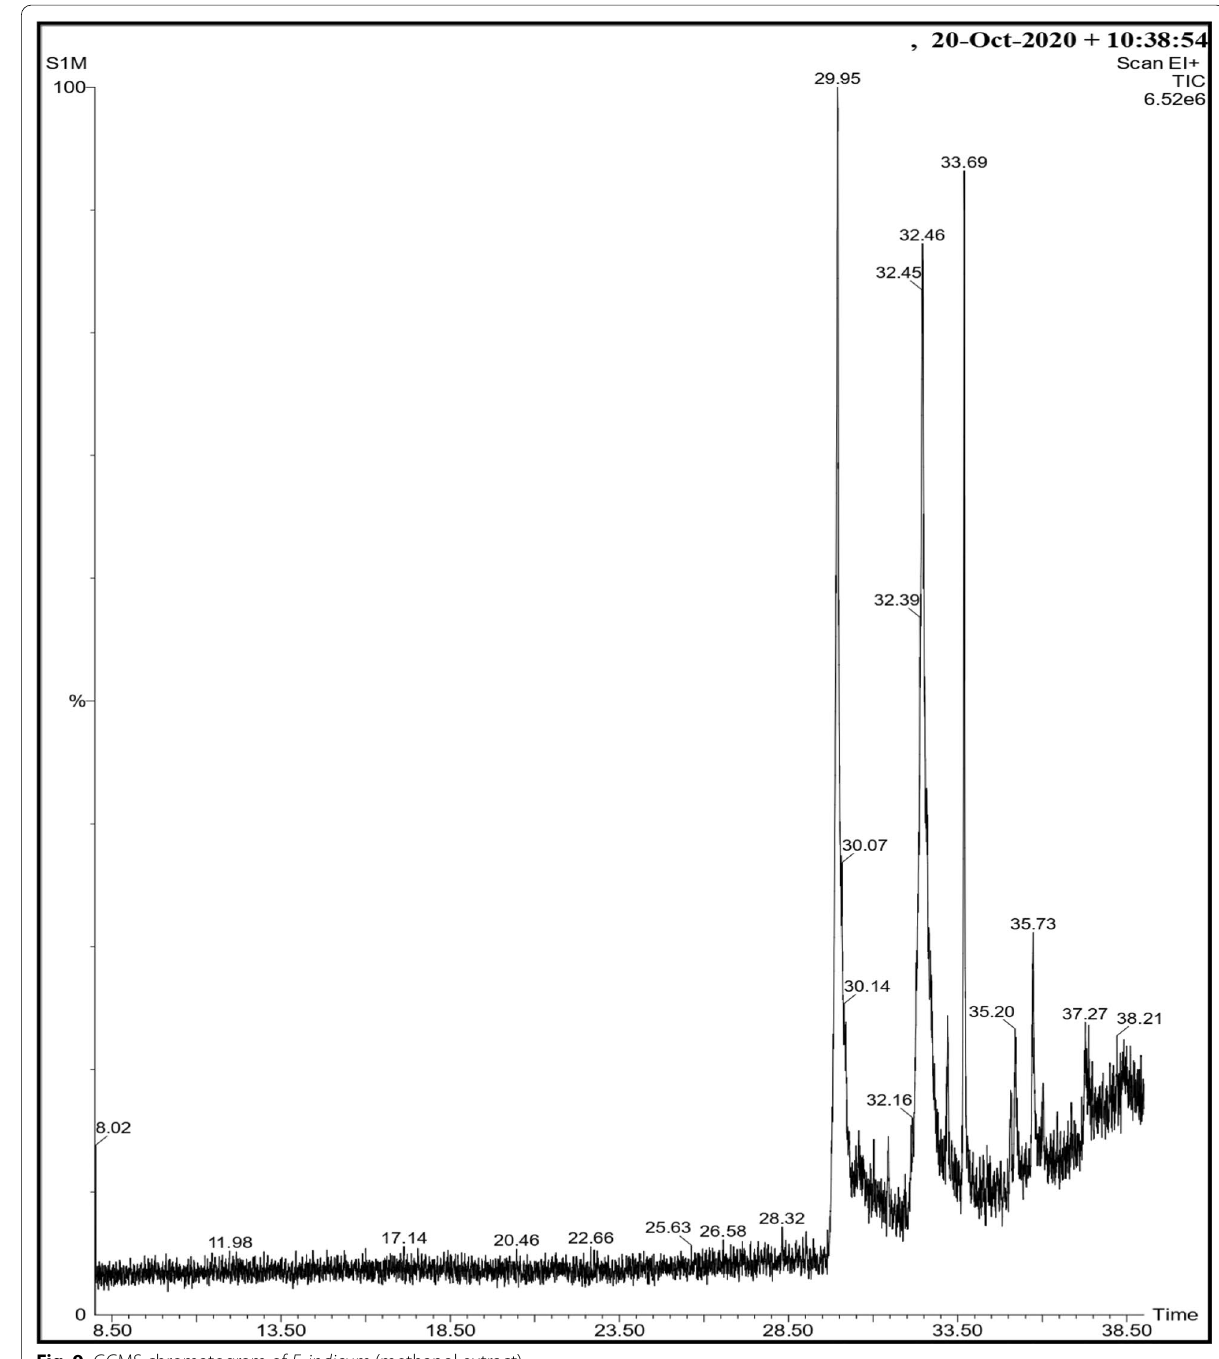
Fig. 9 GCMS chromatogram of E. indicum (methanol